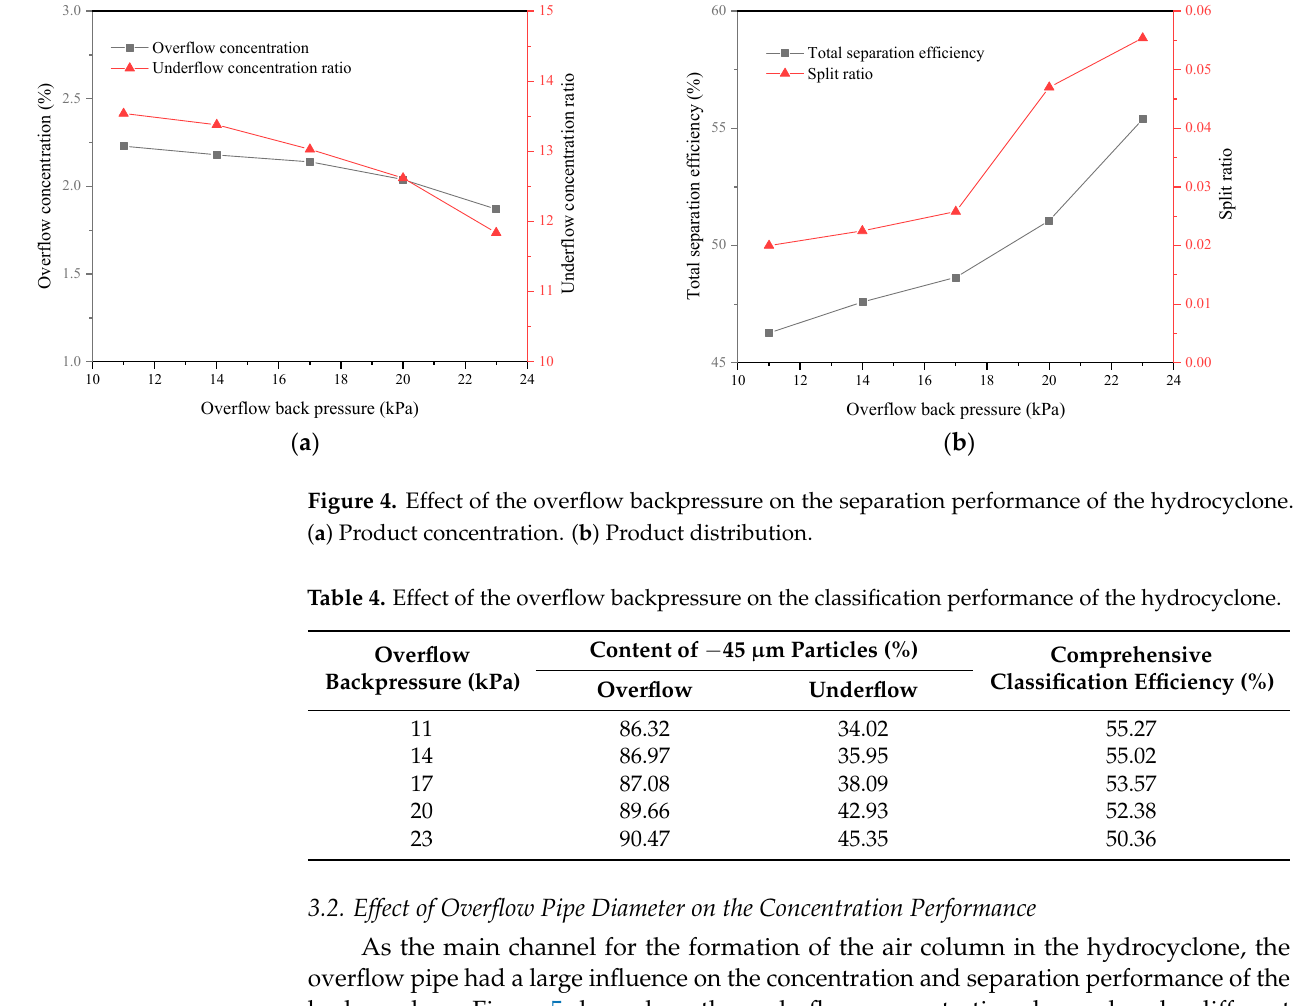
Table 4. Effect of the overflow backpressure on the classification performance of the hydrocyclone. Overflow